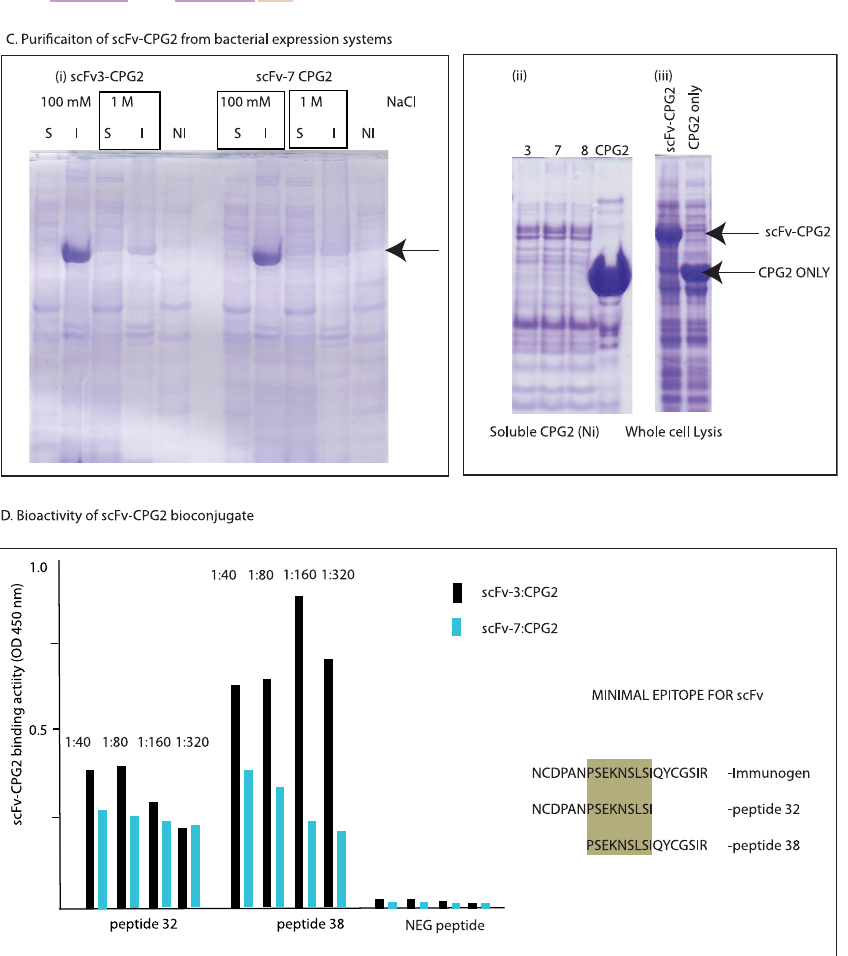
PLOS ONE | DOI:10.1371/journal.pone.0148366 February 19,